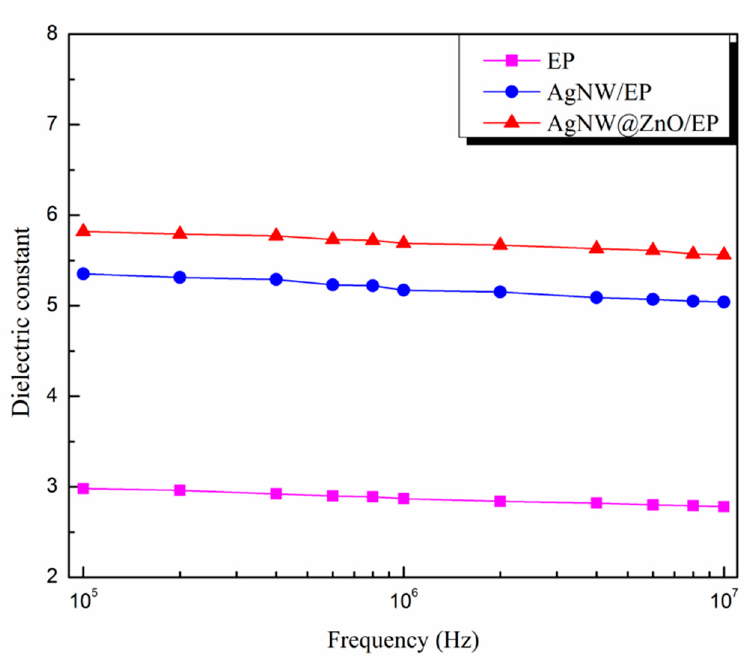
Figure 11. Dielectric constant of EP, AgNW/EP, and AgNW@ZnO/EP composites.